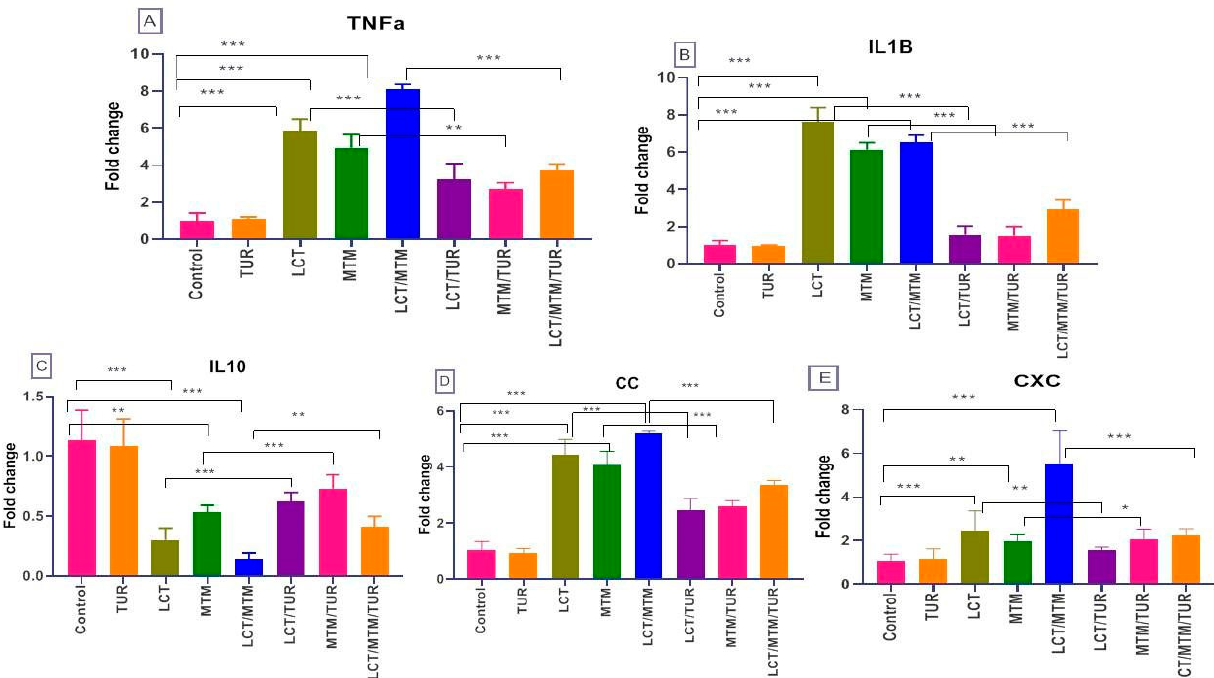
Figure 3. Fold changes in TNF- α , IL-10, IL-1 β , CC, and CXC expression of O. niloticus after exposure to LCT and/or MTM (1/20 of LC50) and fed a diet containing 1% taurine (TUR) for 60 days. The values are shown as means ± SEs. One-way ANOVA followed by Tukey post hoc tests to measure the significance of differences between groups. *— p ≤ 0.05 (low significance); **— p ≤ 0.01 (moderate significance); ***— p < 0.001 (highly significant difference). The comparisons are represented in the figure as LCT versus LCT + TUR, MTM versus MTM + TUR, and LCT + MTM versus LCT + MTM +TUR.